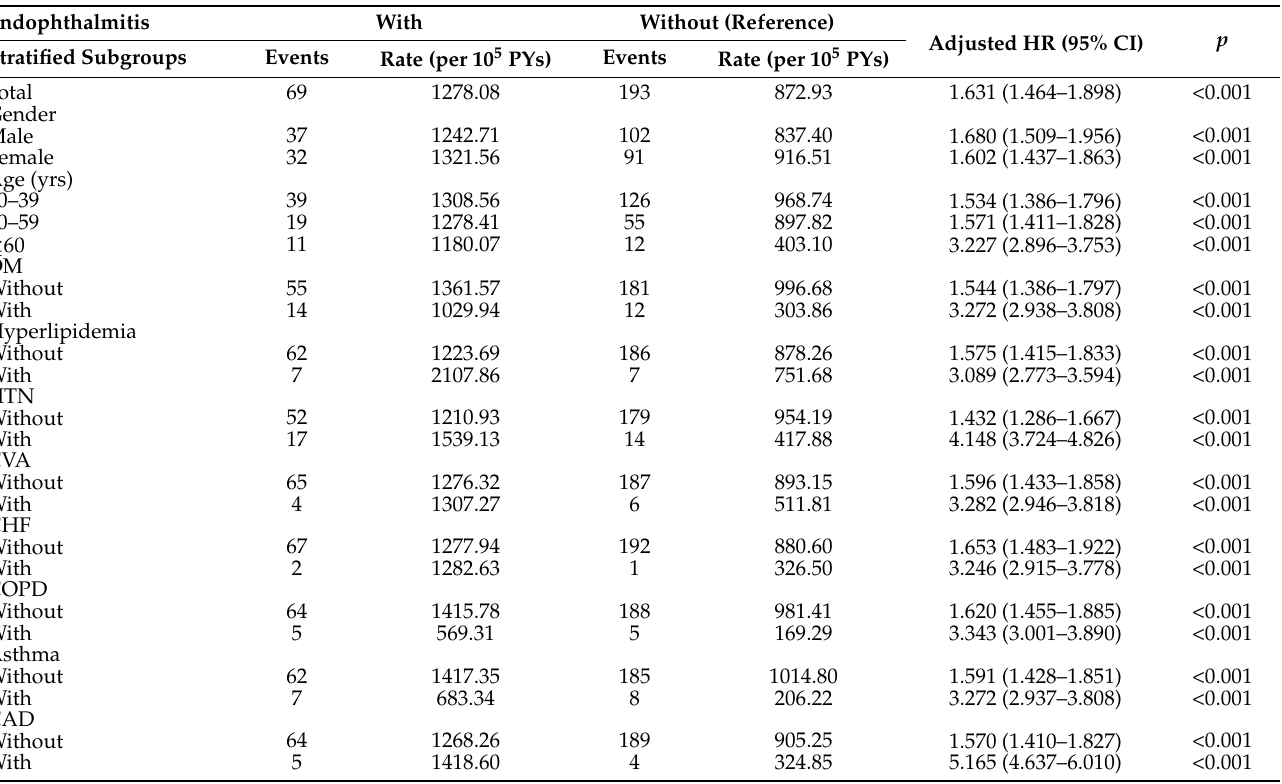
Table 3. Risk analysis of AMI between patients with and without endophthalmitis in subgroups stratified with clinical